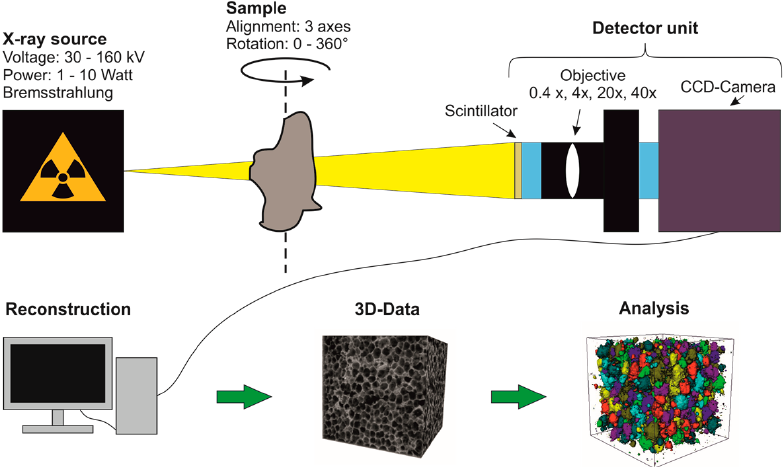
Figure 6. Functionality of the measurement and preparation of high-resolution X-ray computed tomography [22].